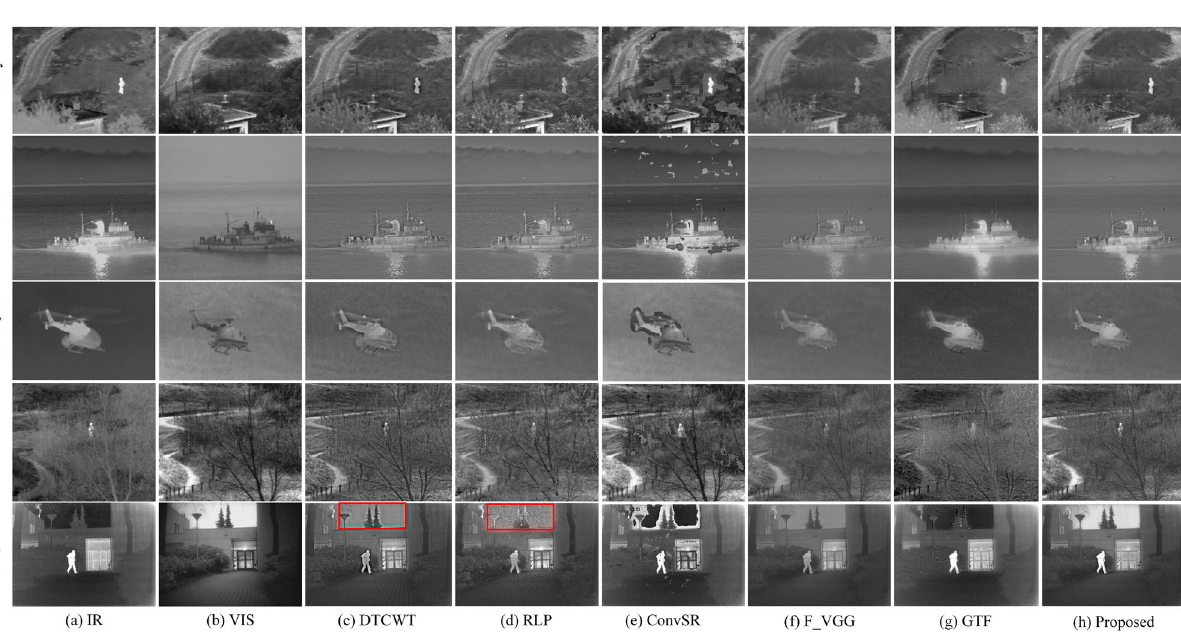
Figure 9. Comparison of fusion results from different methods on the “Sentry”, “Boat”, “Helicopter”, “Wilderness” and “People” source